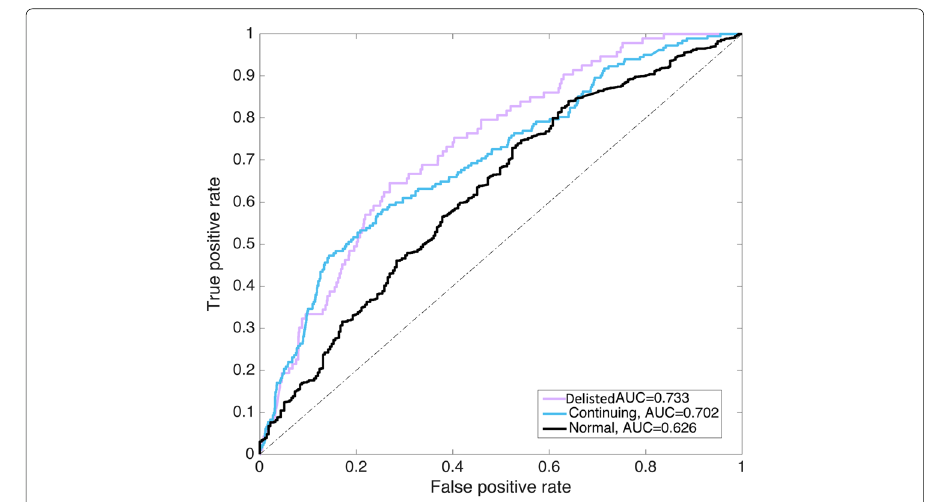
Fig. 6 One-vs-rest ROC analysis of three groups of stocks in